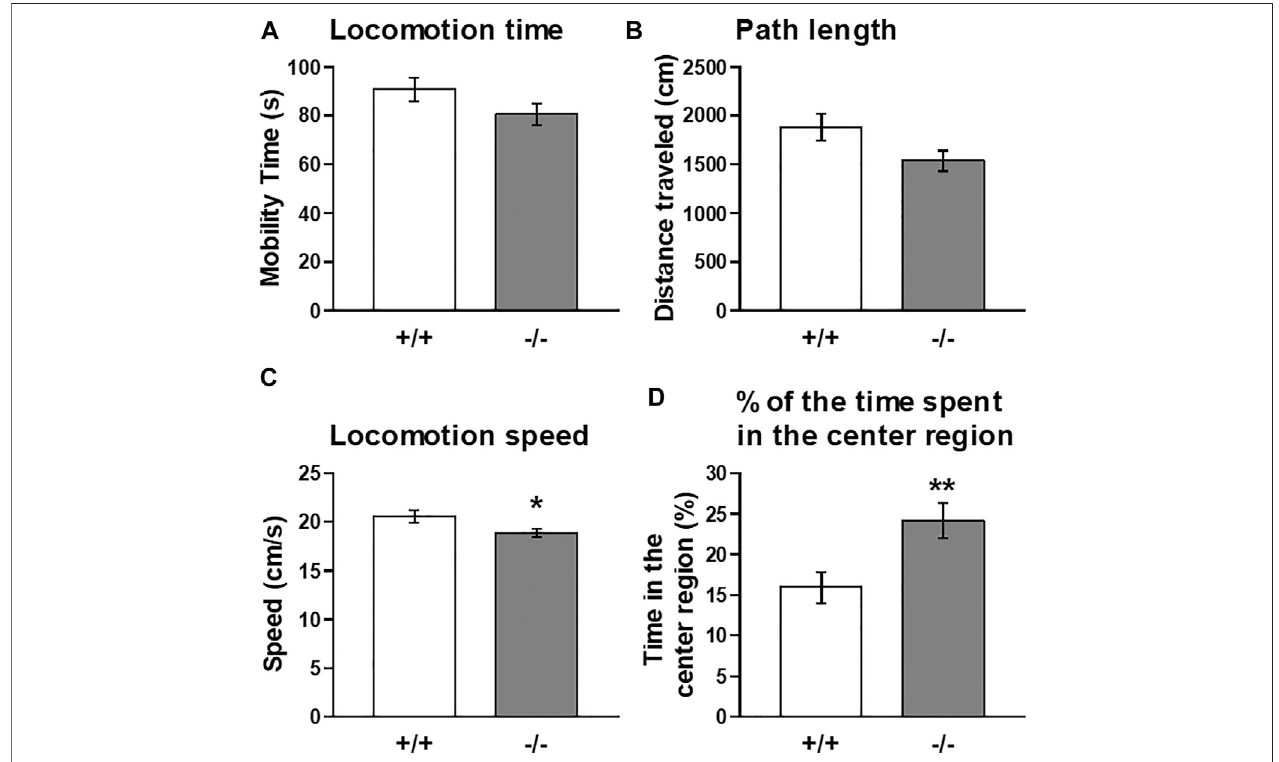
FIGURE3| Basallocomotor activityinFFAR1+/+and − / − miceinresponsetoanovelenvironment.Anopen- fi eldtestforatotalof5 minshowedaslightreduction inlocomotiontime (A) andpathlength (B) in − / − mice.However,signi fi cantdifferencesinlocomotionspeed (C) andthepercentageofthetimespentinthecenterregion (D) were noticed in the − / − mice. * p < 0.05, ** p < 0.01 vs. +/+ mice (Student ’ s t -test). n (cid:2) 15 per genotype.